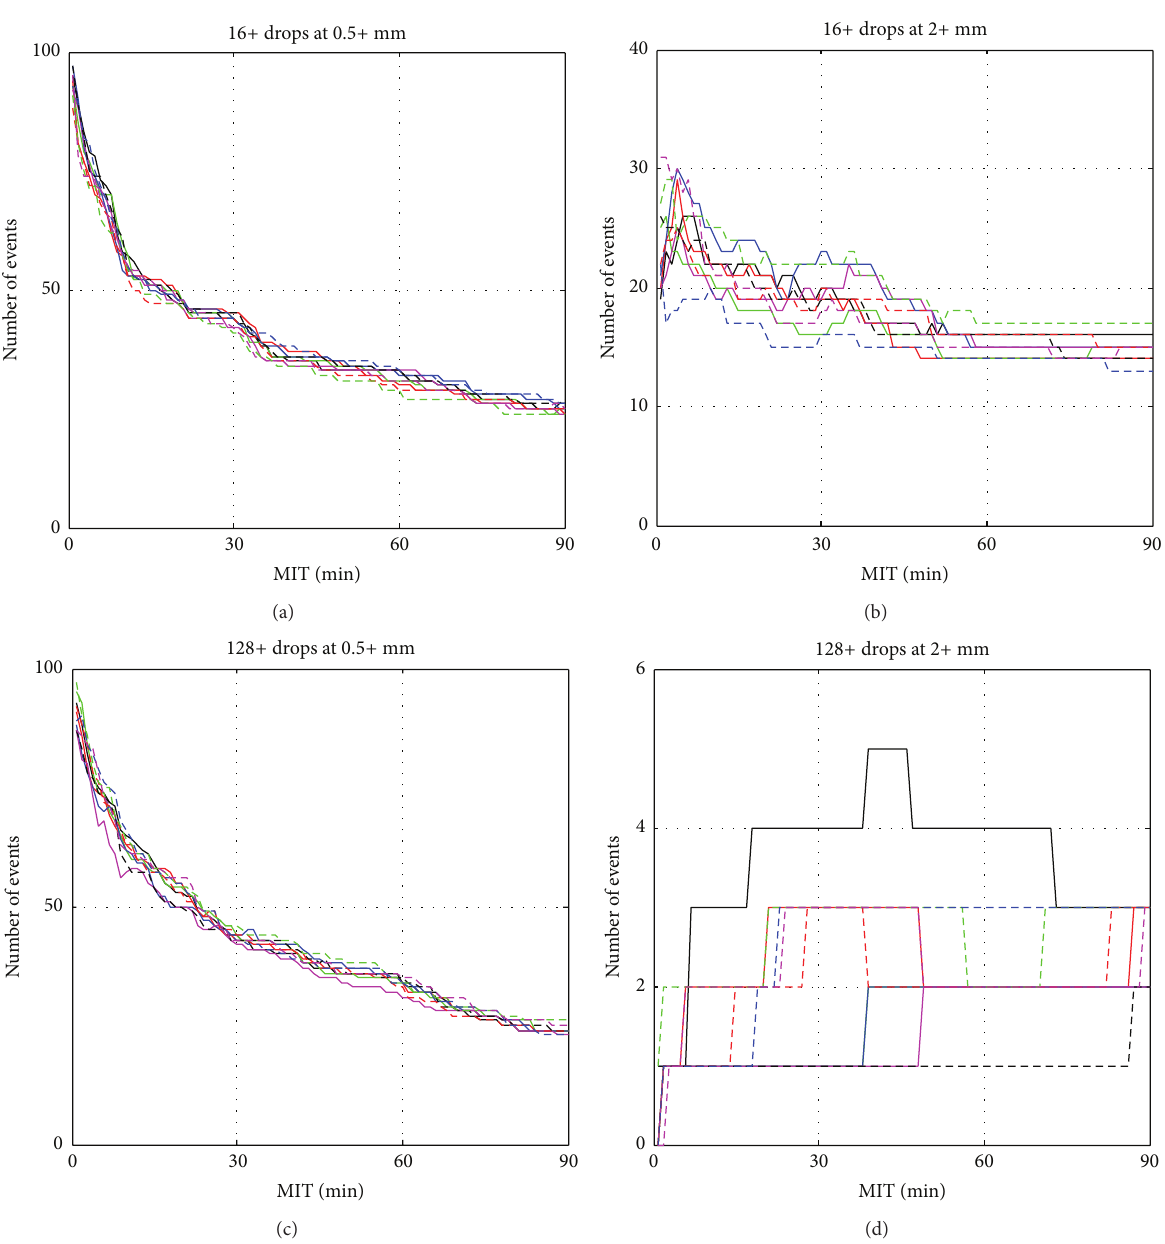
Figure 7: Part of the parameter space explored in the search for combinations of MIT, L , N , and D that report the same number of events across the whole array. For these figures, L (the minimum number of rainy minutes required to constitute an event) is constrained to be 10. The 𝑥 -axis on all plots shows different possible values for MIT (in minutes). There are 10 curves in each plot indicating the 10 detectors. The values of N and D are specified in the title for each panel. It appears that none of the values shown on this figure give completely unambiguous definitions for the number of events that hold for all detectors in the